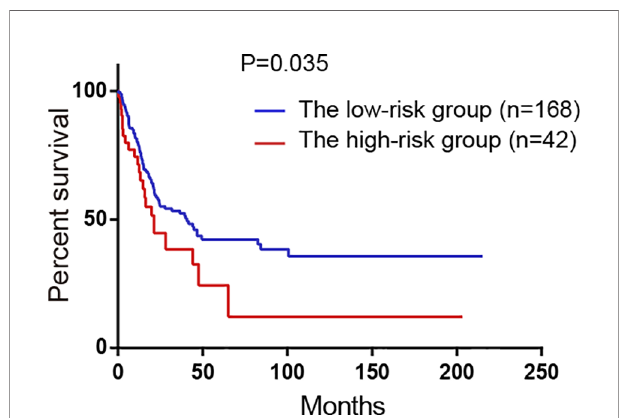
FIGURE 6 | Survival analysis of the high-risk group and the low-risk group divided by the model in GSE65904 validation set. All 214 patients were classi fi ed into two groups: the high-risk group and the low-risk group by the optimal cut-off value of risk